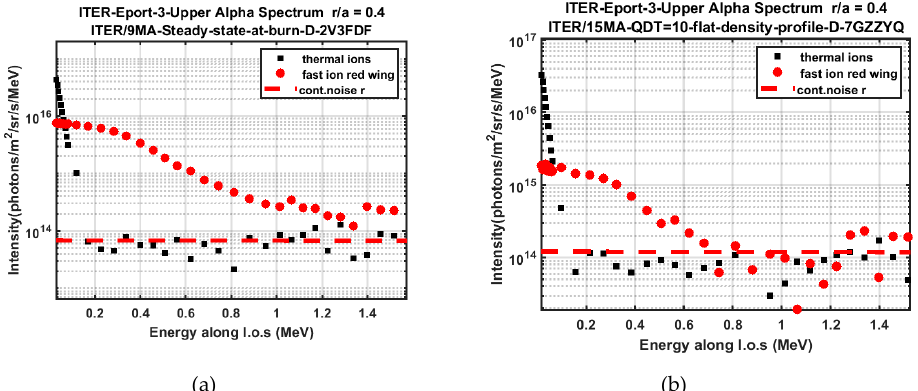
Figure 21. ( a )Predicted CXRS alpha particle energy spectrum. E-port-3-Upper, DNB, high-throughput broad-band spectrometer F1.8, disp 0.8 nm/mm, 0.5 s, slit 1 × 12 mm, energy binning 50 keV